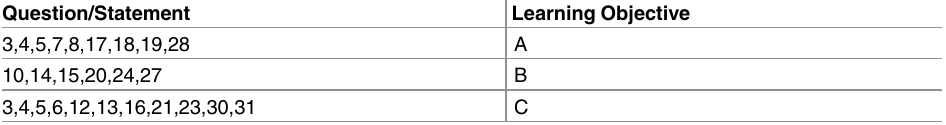
Table 1. Categorization of questionnaire questions by learning objective. Questions used in this survey were closely adaptedfrom previous CLASS surveys [14–16].Categoriesare as in Semsar et al. 2011. The learningobjectivecolumn lists the stated learningobjectives * of the moduleas they are addressed by the statements/questions on the survey.